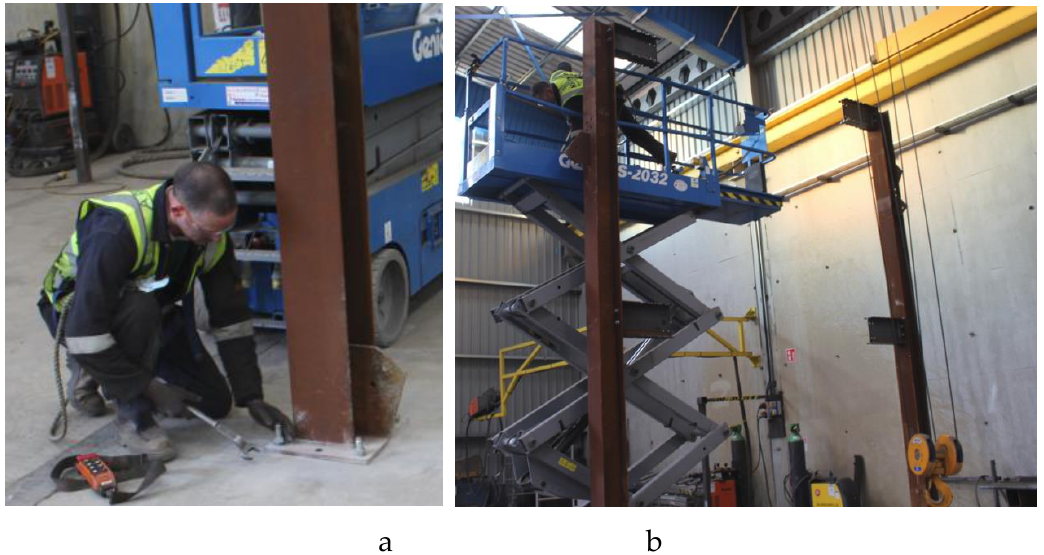
Figure 16. Initial steps of frame erection: ( a ) tightening of column holding down bolts; ( b ) overall view of the frame stub beams.